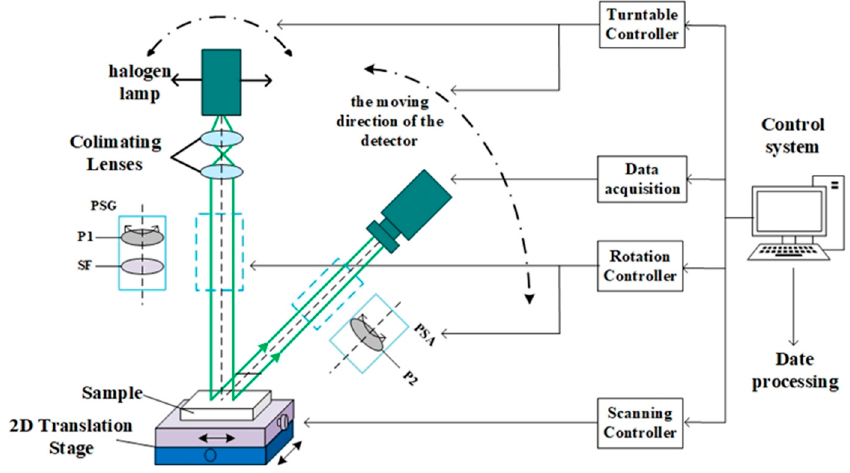
Figure 2. Typical target material polarization spectrum scattering characteristics test system. PSA, polarization state detector, PSG, polarization state generator, P1 and P2, linear polarizer, SF, spectral filter.